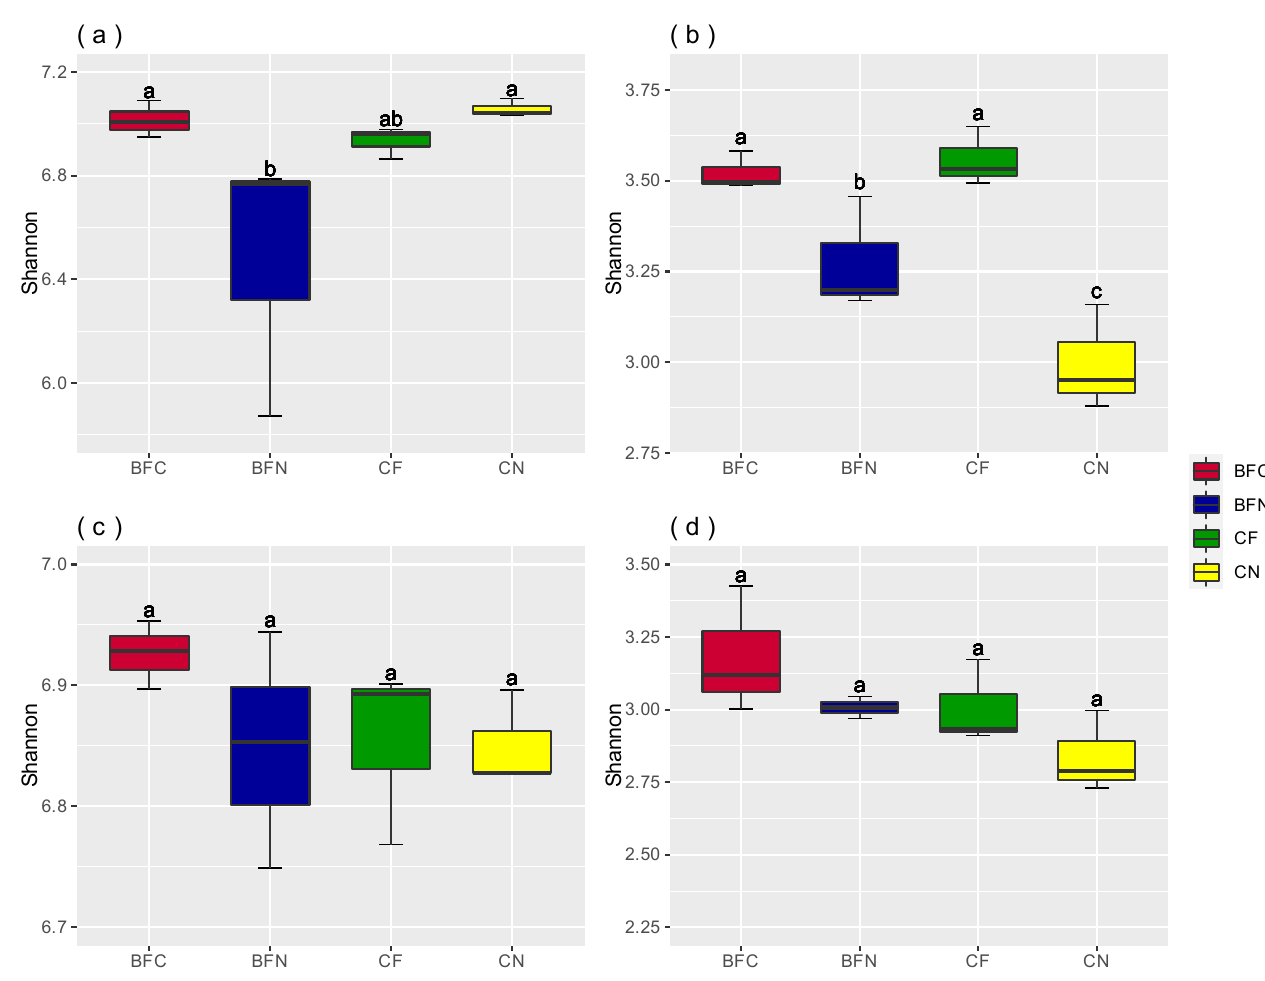
Figure 1. Shannon indices of soil bacteria and fungi 15 days after transplanting ( a , b ) and fruiting stages ( c , d ), respectively ( p ≤ 0.05).